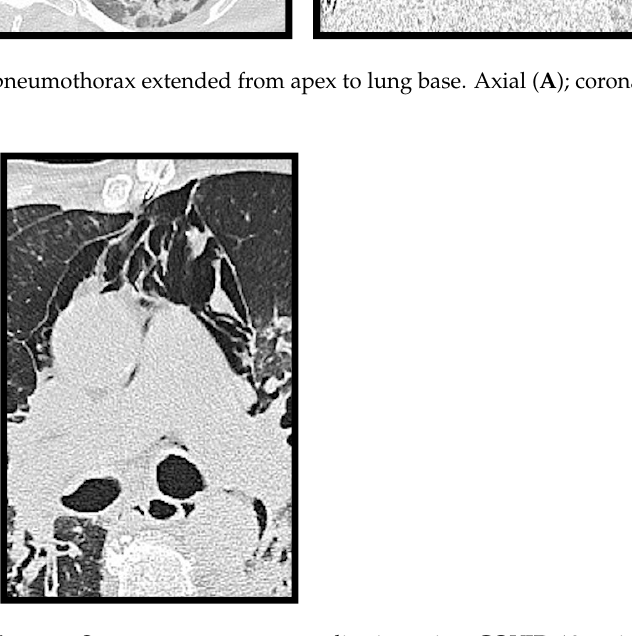
Figure 8. Spontaneous pneumomediastinum in a COVID-19 patient. Loffi et al. [26] identified 6 cases of spontaneous pneumomediastinum in 102 COVID- 19 patients investigated with CT examination (6%). They asserted that spontaneous pneumomediastinum is a possible complication of severe COVID-19 pneumonia and can affect patient management and clinical outcomes. In fact, in their experience “the concomitant presentation of spontaneous pneumomediastinum and diffuse COVID-19 pneumonia was associated with a severe clinical course characterized by sudden ARDS that required aggressive management and early intubation in three patients”. Table 1 summarizes all the studies reported in Section 2: Adult “Atypical” and “Complicated” Pulmonary COVID-19. Table 1. Adults “atypical” and “complicated” pulmonary COVID-19. Lymphadenopath y